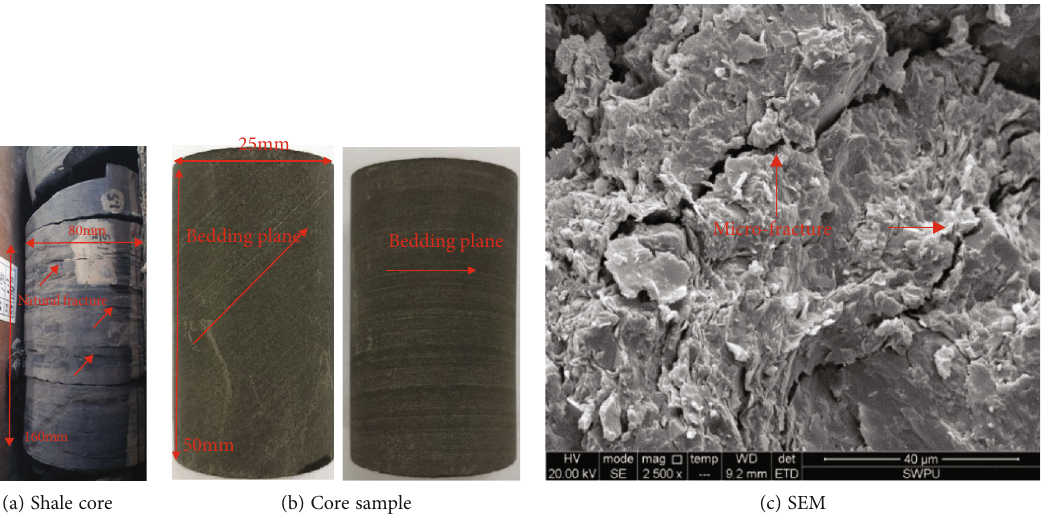
Figure 1: Image of shale structure.